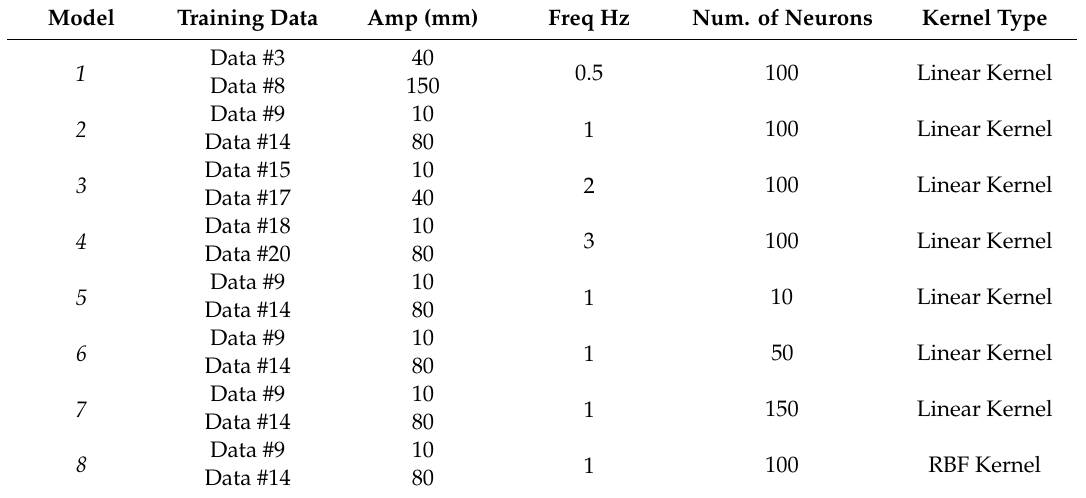
Table 6. LS-SVM model